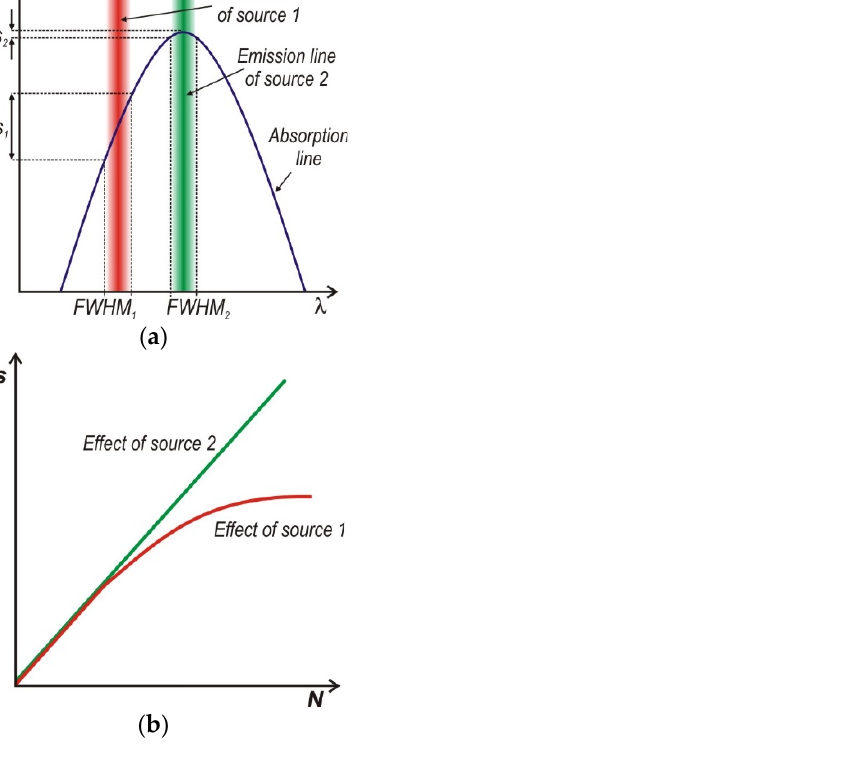
Figure 4. Illustration of the imprecise matching of the emission line of the radiation source to the maximum of the absorption line ( a ) and the effect on the absorbance ( b ).